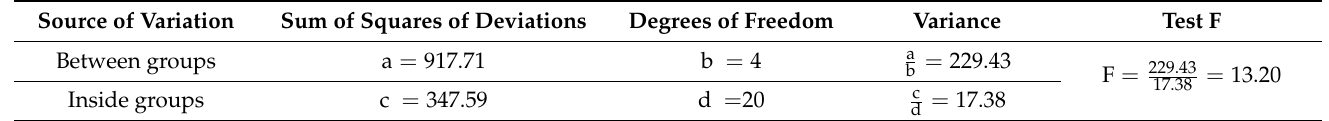
Table 4. Values of the F test statistic by ANOVA analysis of